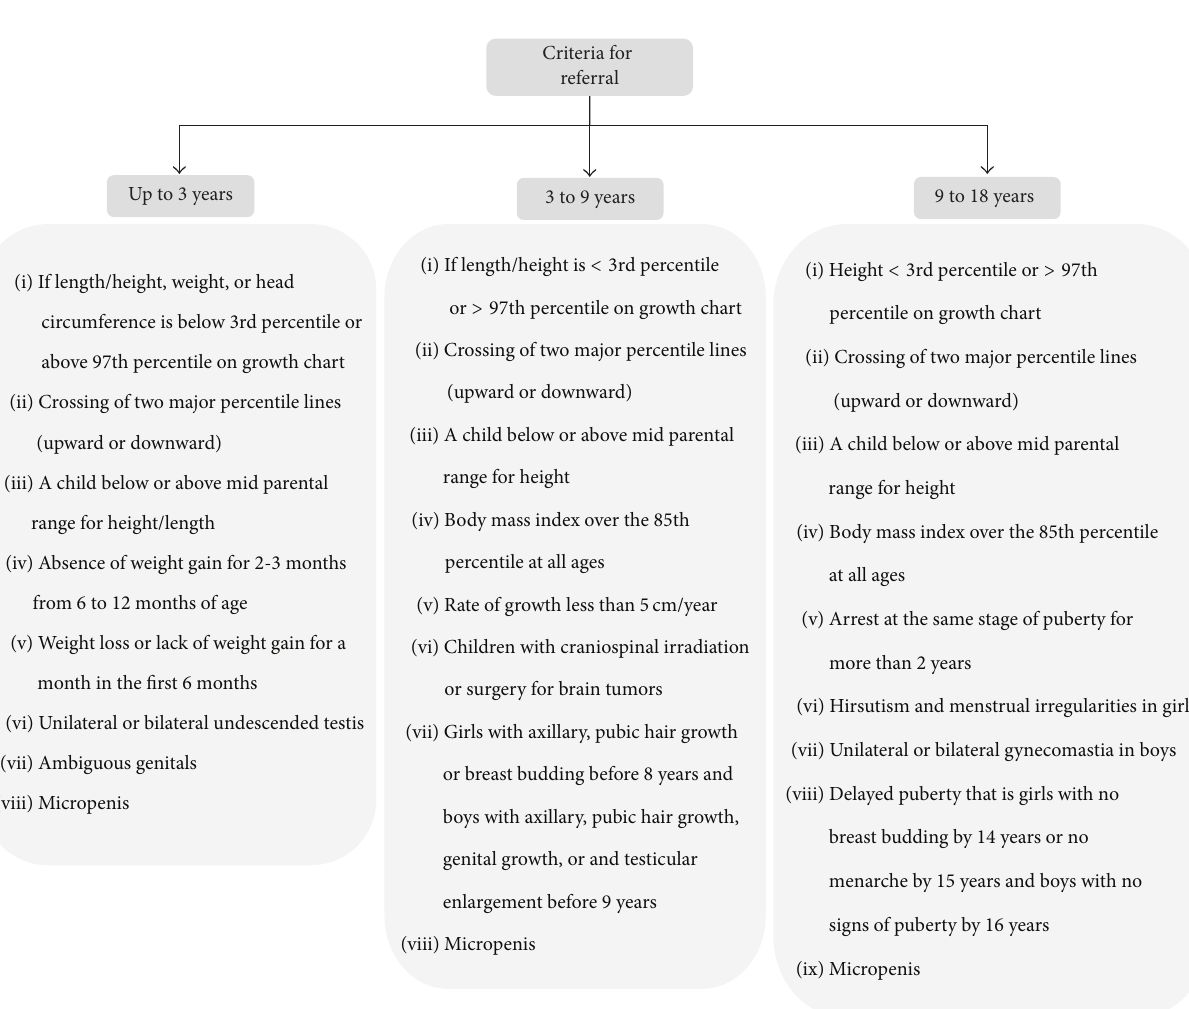
Figure 2: Criteria for